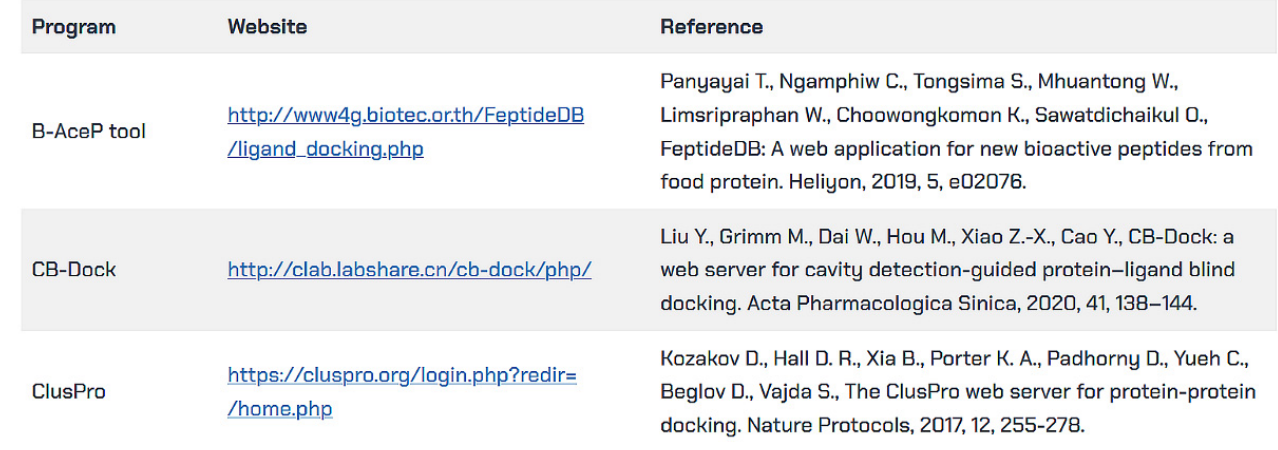
Figure 6. Screenshot of a fragment of the content of the “Docking” tab (see Figure 1). B-AceP tool [24], CB-Dock [25], and ClusPro [26] programs serve as